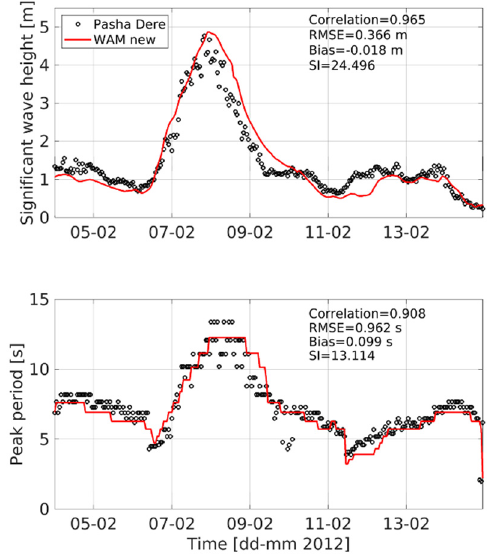
Figure 16. Significant wave height and peak period from WAM (using the BS-WAV MY system) and from the ADCP station Pasha Dere from 4 to 15 February 2012.